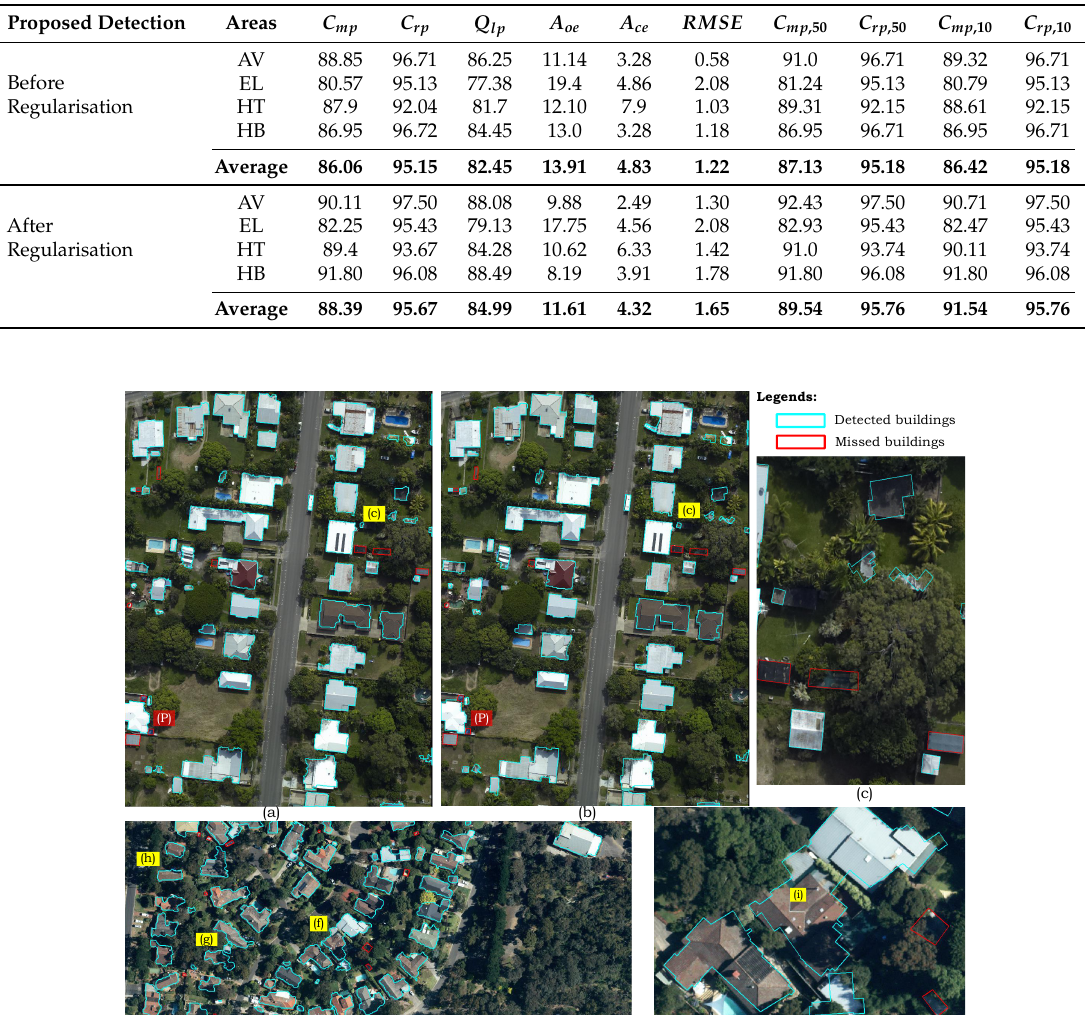
Table 5. Pixel-based building detection results on Australian data sets before and after regularisation stage. ( C mp = completeness, C rp = correctness and Q lp = quality are for all the buildings, 50 m 2 and over 10 m 2 ; A oe = area omission error and A ce = area commission error; in percentage, RMSE = planimetric accuracy in metres).